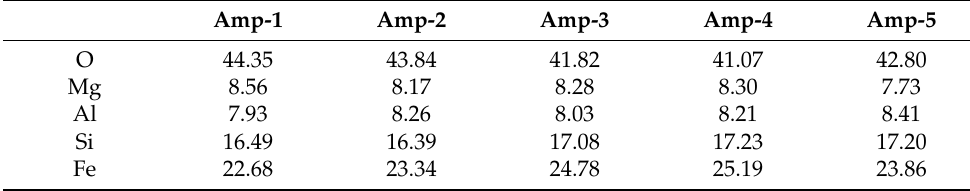
Figure 8. Common terrigenic component of investigated samples: ( a ) potassium feldspar, ( b ) plagioclase, ( c ) amphibole, ( d ) rutile, ( e ) iron oxide and ( f ) xenotime. Table 6. Elemental composition of analysed amphibole grains. Data given in